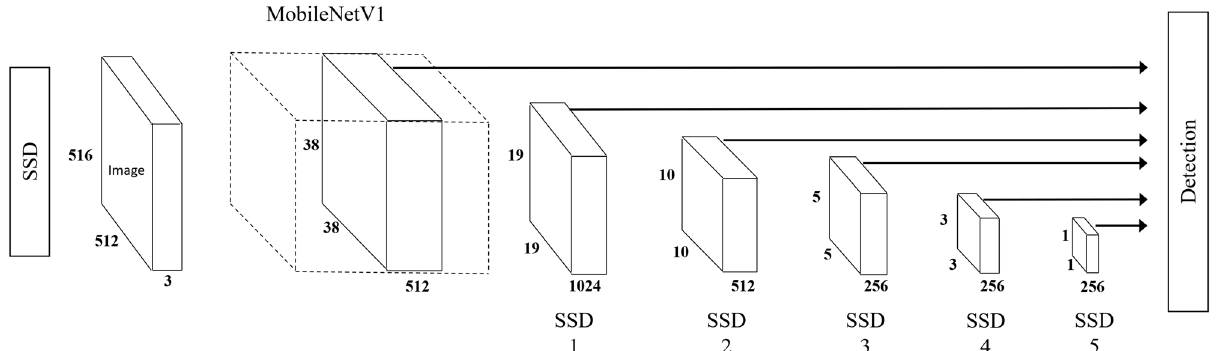
Figure 1. Diagram showing SSD 28 using MobileNetV1 27 as